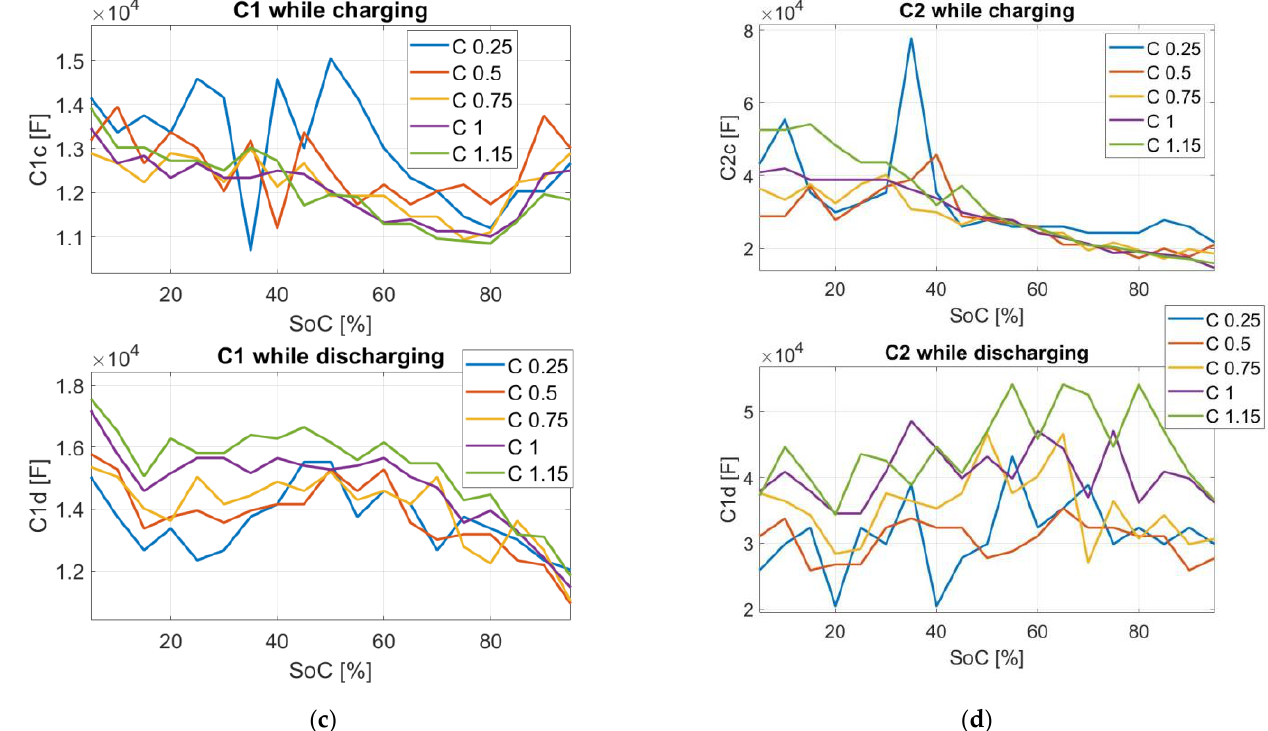
Figure 5. Evolution of the EEC parameters for ( a ) activation polarization resistor; ( b ) concentration polarization resistor, ( c ) activation polarization capacitor; ( d ) concentration polarization capacitor.